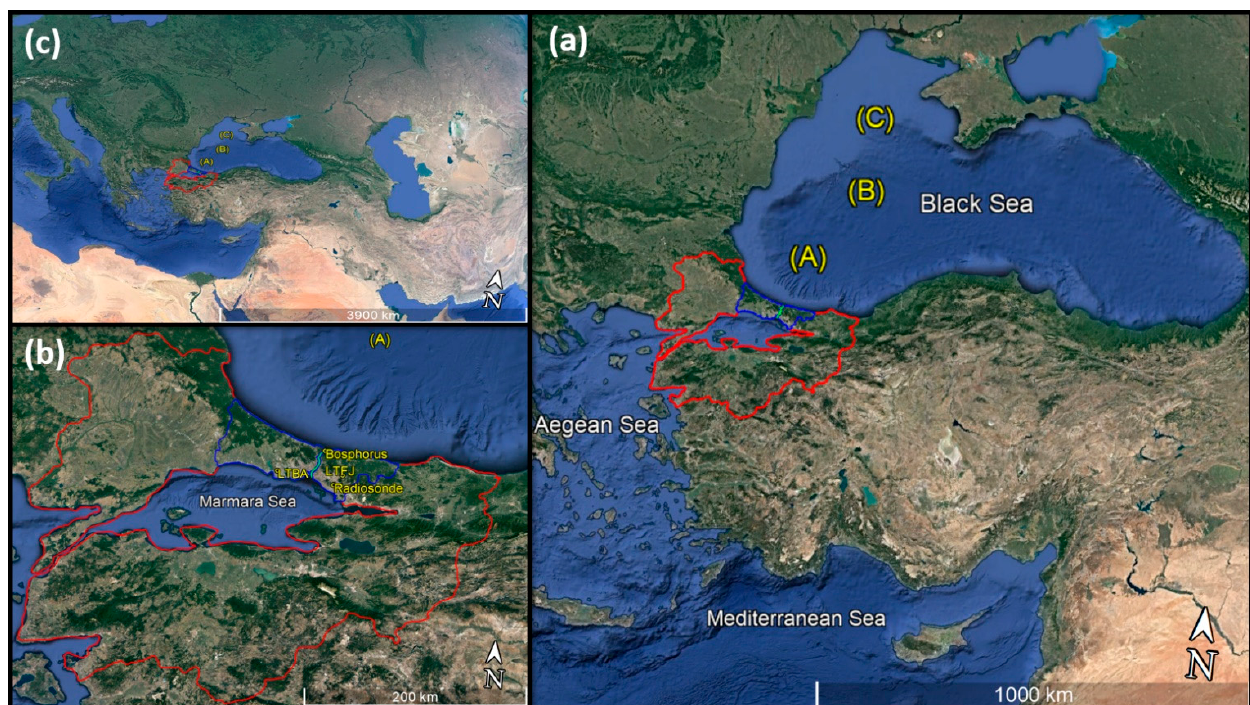
Figure 1. Study area. The large black rectangle shows the study area ( a ), the black square in the lower left shows the study area in detail ( b ), and the black square in the top left shows the study area in large scale ( c ). The area covered with red lines shows the Marmara Region. The area covered with blue lines within the red lines shows Istanbul. The green line, which cuts the blue lined area almost in half, represents the Bosphorus. The west of this line is the European Continent, and the east is the Asian Continent. The locations of LTBA, LTFJ, and Istanbul Kartal Radiosonde Station are indicated in the figure. The coordinate information of points A, B, and C are as follows, respec- tively: 29.5° E, 42.5° N; 30.5° E, 43.5° N; 30.5° E, 44.5° N.